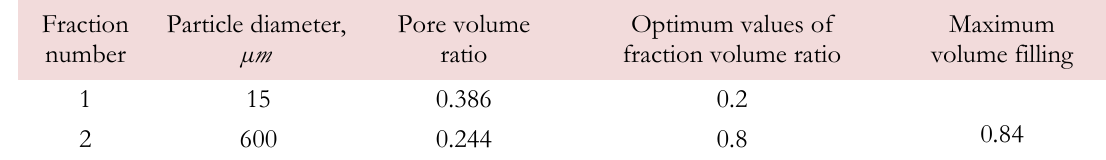
Т able 1: Parameter values of mixtures of two silica